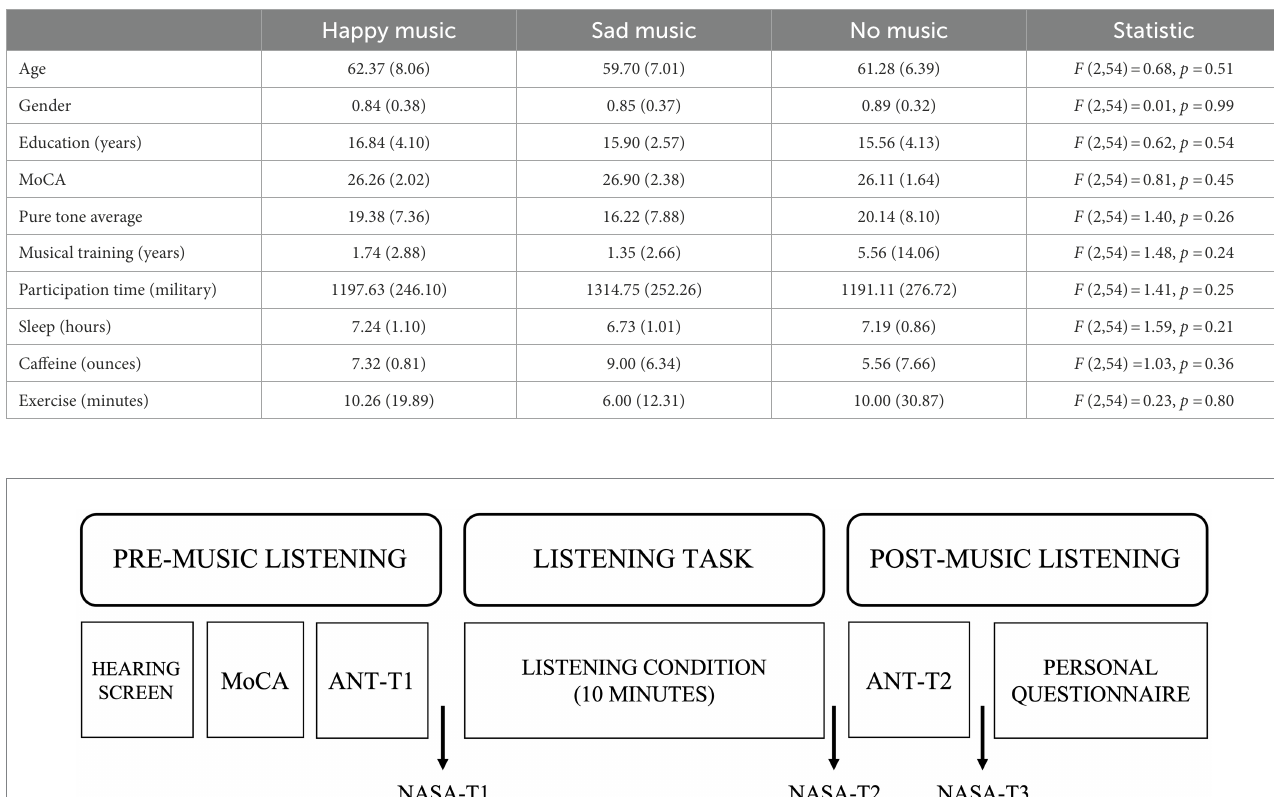
TABLE 1 Means and standard deviations (in parentheses) for the demographic and study specific comparisons between the happy ( n = 19), sad ( n = 20), and no music ( n = 18) listening groups.